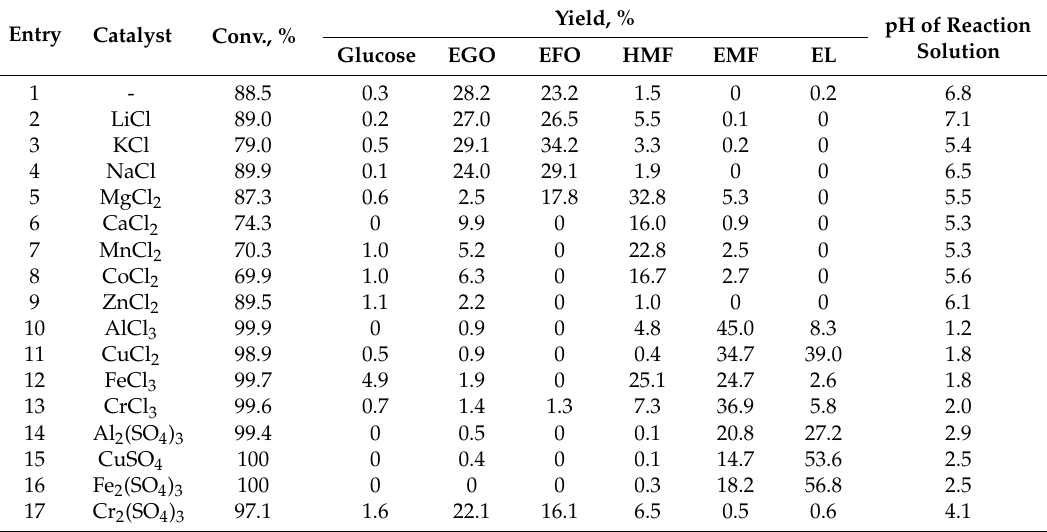
Table 1. Conversion of fructose in ethanol medium with various metal